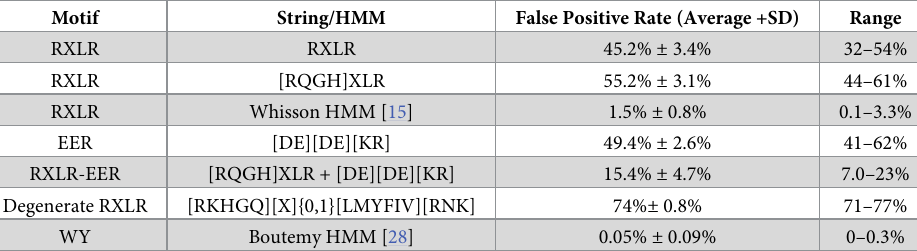
Table 1. False positive rates for HMM and string searches across 14 oomycete